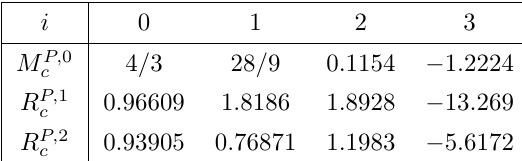
Table 3 . Perturbative coe(cid:14)cients M P; 0 of moments (rest of rows) for the charm pseudo-scalar current correlator. We show only terms which do not involve